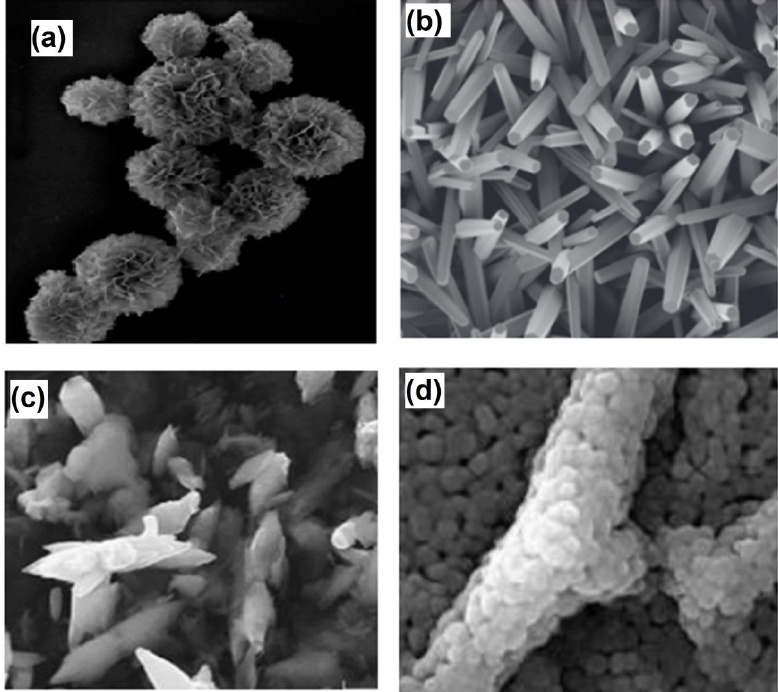
Figure 10. SEM images of ZnO nanoparticles achievable by varying CBD bath parameters. In ( a ) ZnO microflowers, in ( b ) ZnO nanorods, in ( c ) flake-like nanoparticles, and in ( d ) compact nanoparticle